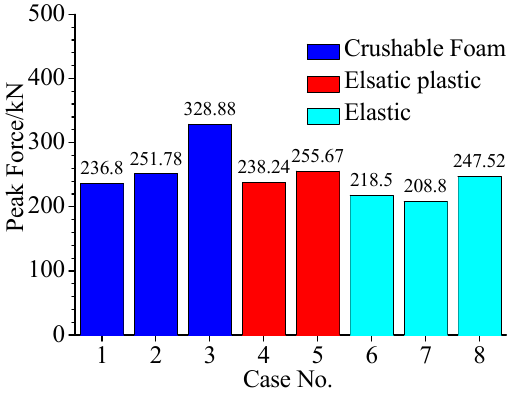
Figure 28. Comparison of peak forces using different ice material models.